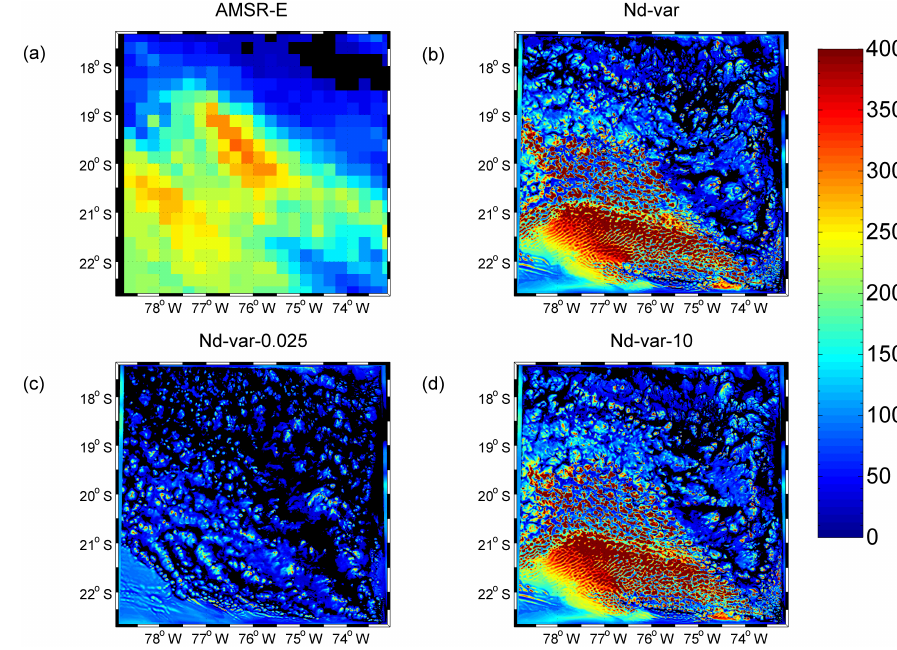
Figure 7. As for Fig. 6, except for nighttime (01:42LST for AMSR-E and 02:12LST for the model).